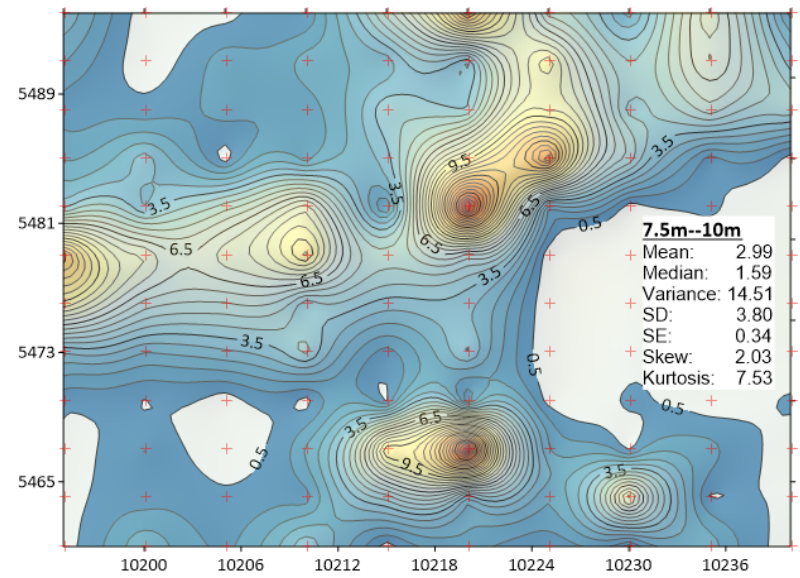
Figure A4. Distribution of ore from RL447.5 to RL445, sampling interval 7.5–10 m, consistent increase of grades with the